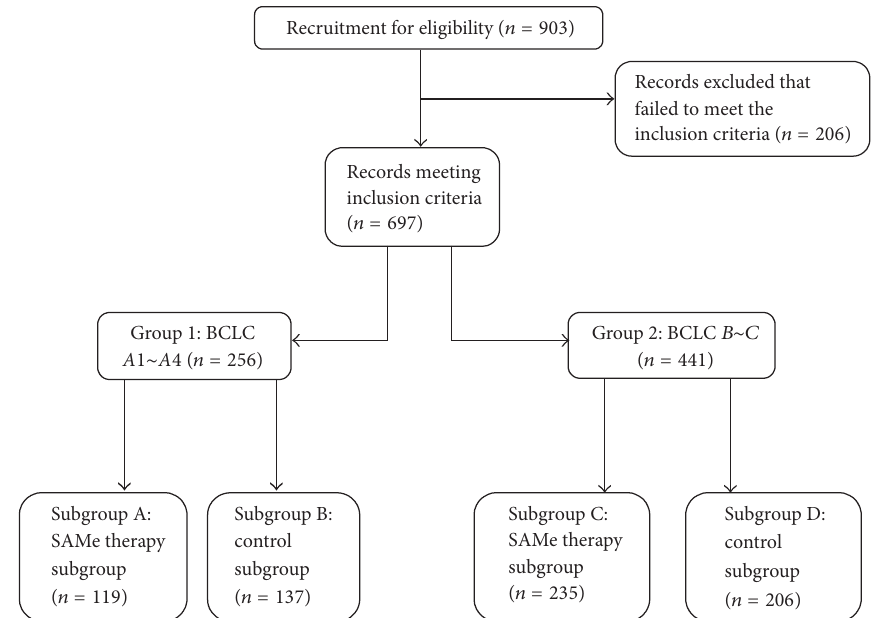
Figure 1: Flow diagram of the process for including patients in this